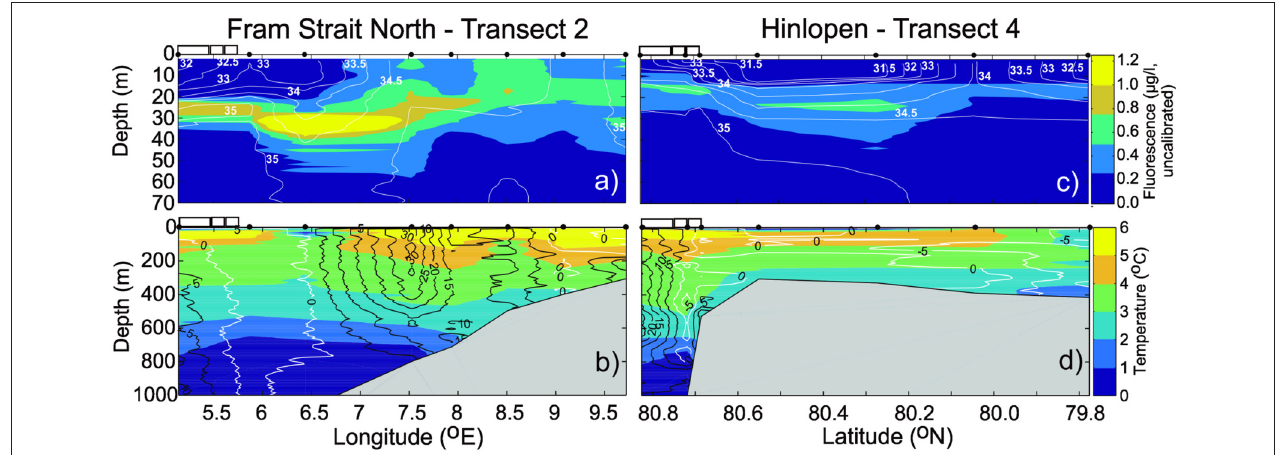
FIGURE 3 | Upper panels show fluorescence (colors) and salinity (lines) in the upper 70m in section Fram Strait North (a) and Hinlopen (c) . Lower panels show temperature (colors) and across section velocity (lines, in cm s − 1 ) in the upper 1,000m in section Fram Strait North (b) and Hinlopen (d) . The white rectangles on top of the plots to the left indicate presence of sea ice. Black filled circles on top of each panel indicate position of CTD stations.